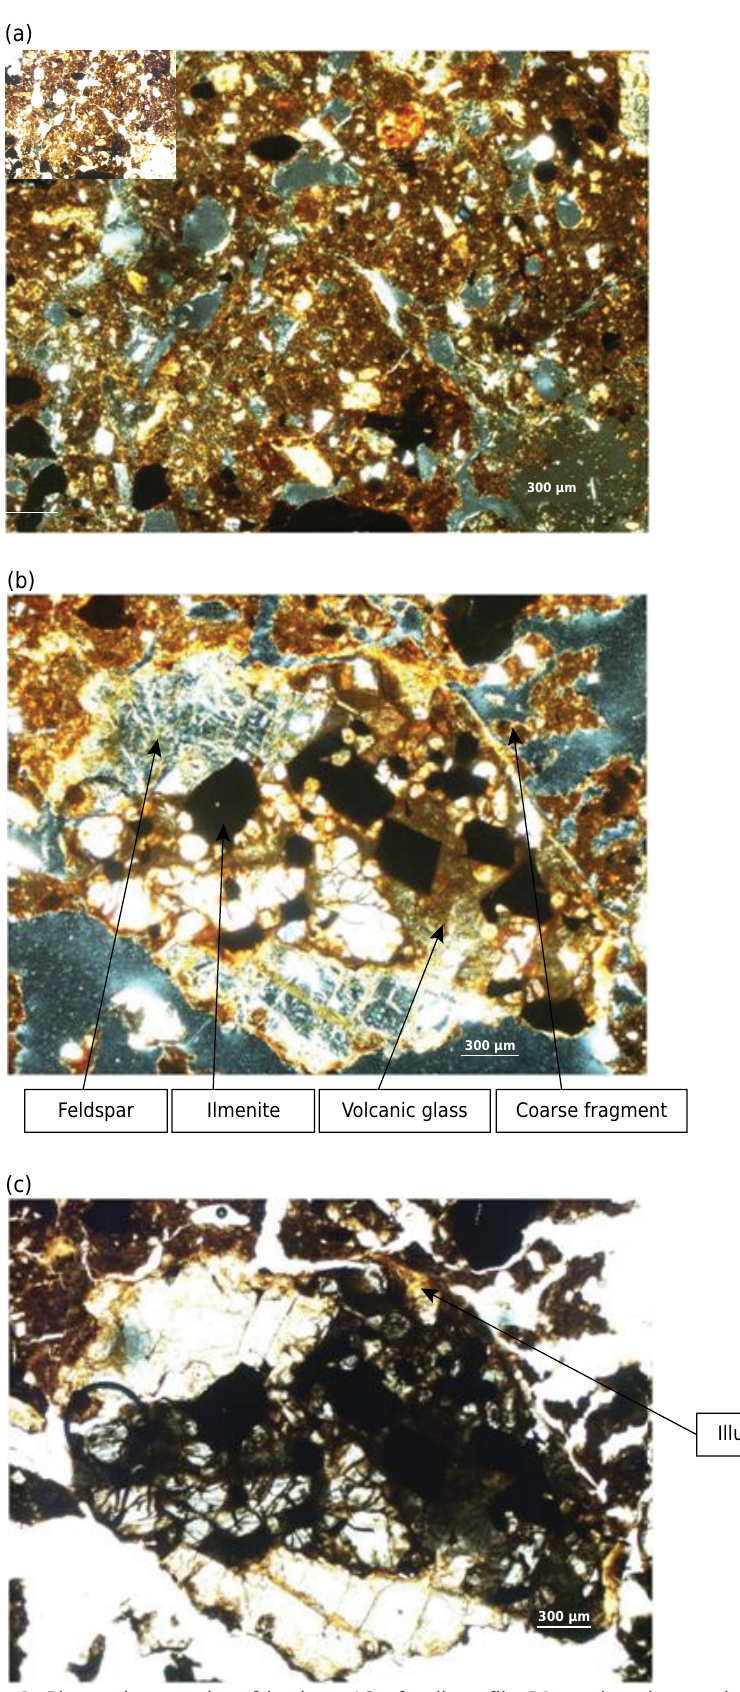
Figure 4. Photomicrographs of horizon A2 of soil profile P1, under plane-polarized light (PPL); (a) groundmass of horizon A2 with open-porphyric fabric, under cross-polarized light (XPL); (b) coarse fragment formed by primary minerals under XPL; (c) coarse fragment with illuvial clay preserved under